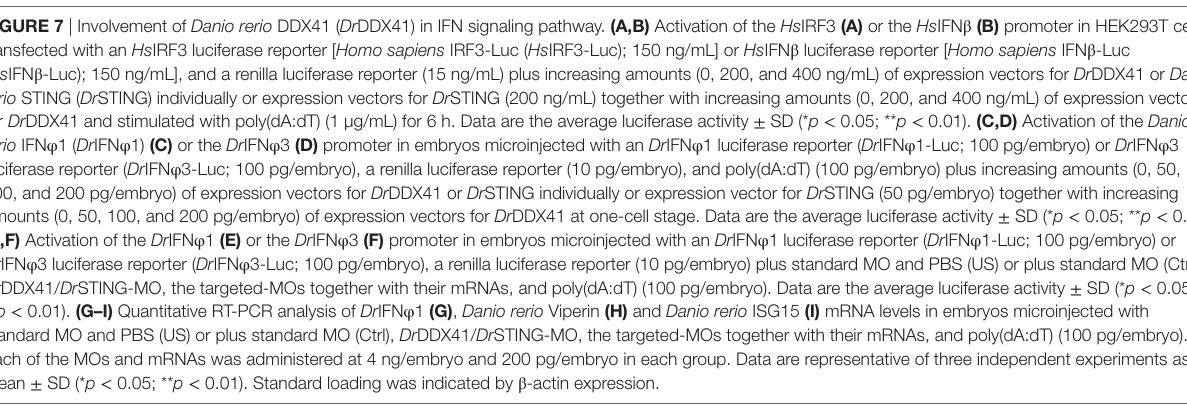
FigUre 7 | Involvement of Danio rerio DDX41 ( Dr DDX41) in IFN signaling pathway. (a,B) Activation of the Hs IRF3 (a) or the Hs IFN β (B) promoter in HEK293T cells transfected with an Hs IRF3 luciferase reporter [ Homo sapiens IRF3-Luc ( Hs IRF3-Luc); 150 ng/mL] or Hs IFN β luciferase reporter [ Homo sapiens IFN β -Luc ( Hs IFN β -Luc); 150 ng/mL], and a renilla luciferase reporter (15 ng/mL) plus increasing amounts (0, 200, and 400 ng/mL) of expression vectors for Dr DDX41 or Danio rerio STING ( Dr STING) individually or expression vectors for Dr STING (200 ng/mL) together with increasing amounts (0, 200, and 400 ng/mL) of expression